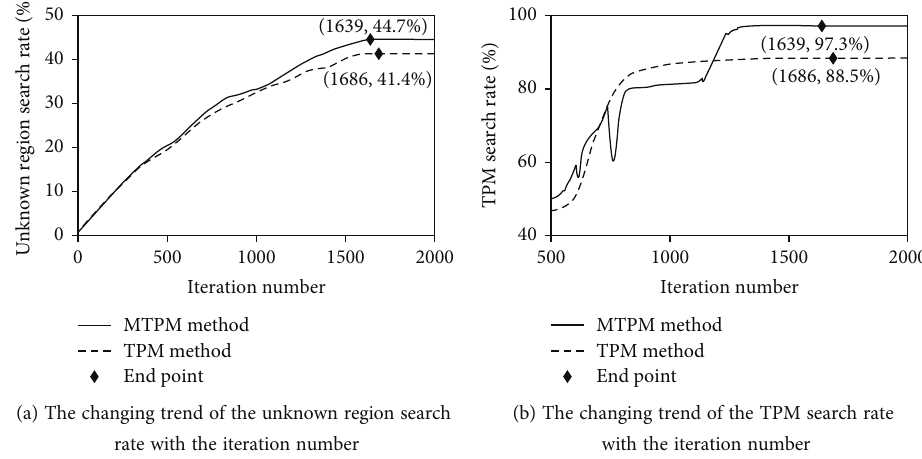
Figure 5: Comparison on the search rate with the iteration number between the two methods.